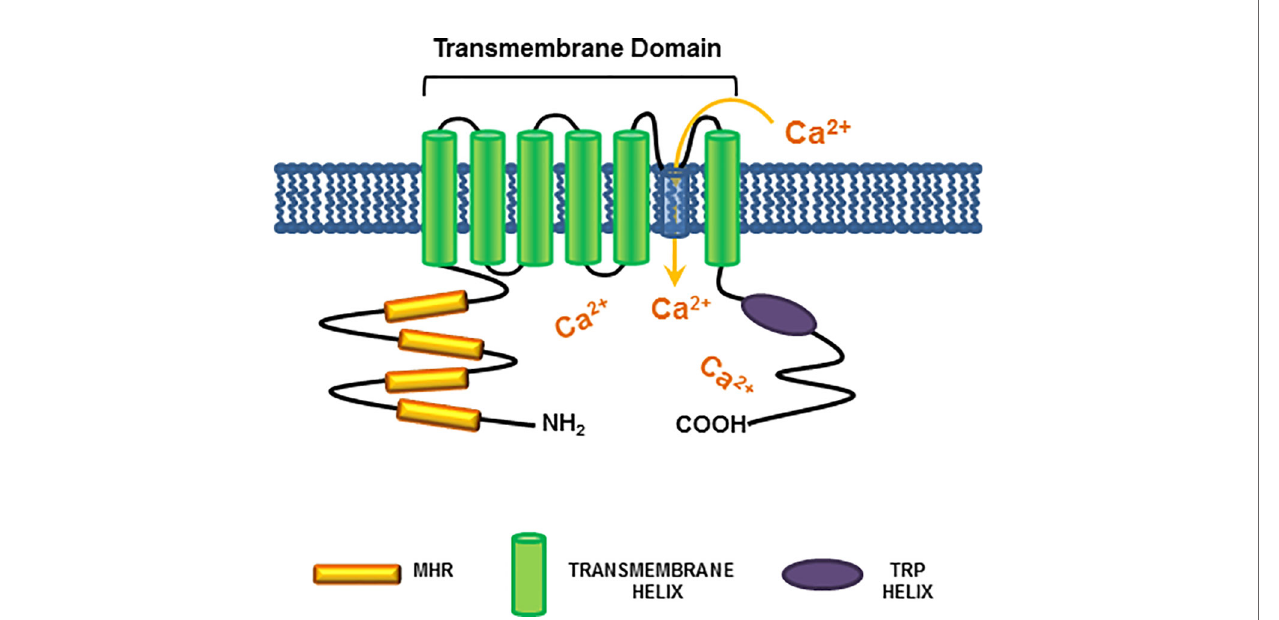
FIGURE 2 | TRPM8 structure. A schematic representation of the TRPM8 channel shows all the common structures between TRPM members. The cytosolic N- terminal region is connected to four Melastatin Homology Regions (MHRs), which are required for channel assembly and ion traf fi cking. The MHRs are connected to six helices within the plasma membrane, which constitute the trans-membrane domain (TMD). At last, the intracellular TRP helix is connected via a coiled-coil domain to the C-terminal domain (CTD). The indicated domains are colored as follows: MHR, orange; TMD helices: green; TRP helix: purple. As indicated in Figure, TRPM8 channel activation leads to an increase in cytosolic calcium